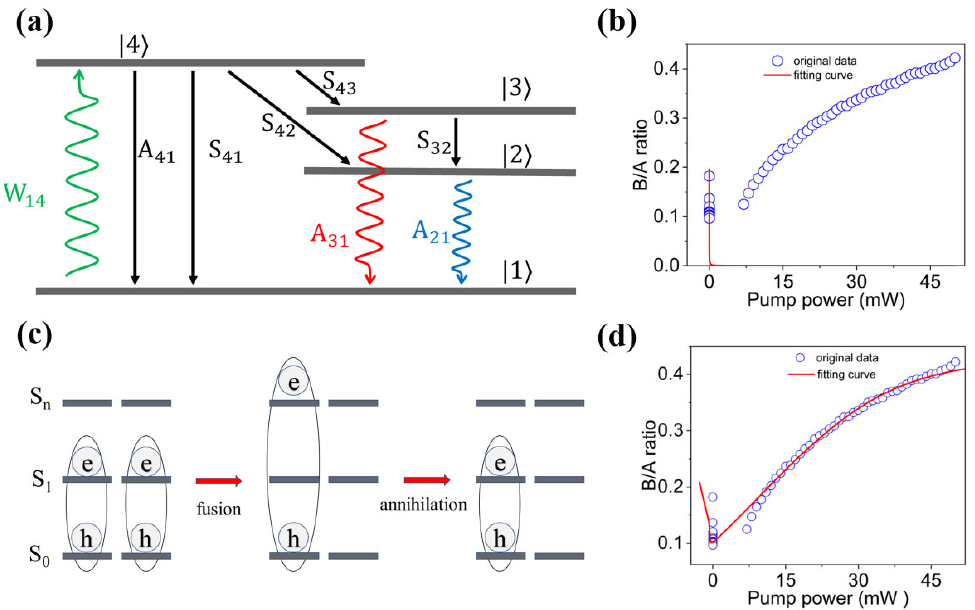
Figure 5. ( a ) Schematic diagram of the exciton state population of the monolayer MoS 2 during exci ‐ tation and recombination processes. ( b ) The theoretical calculation result without EEA ‐ modifica ‐ tion. ( c ) Schematic diagram of exciton − exciton fusion and annihilation processes. ( d ) The theoretical calculation result with EEA ‐ modification.